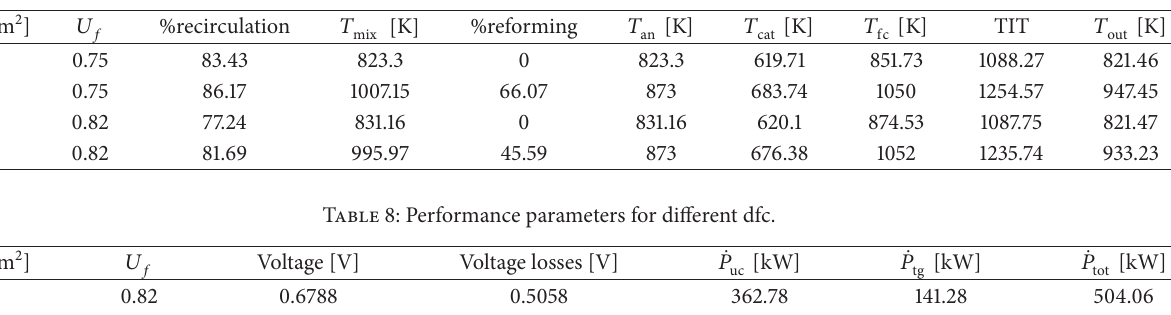
Table 7: Operating parameters in equal value 𝑈 𝑓 for different dfc.